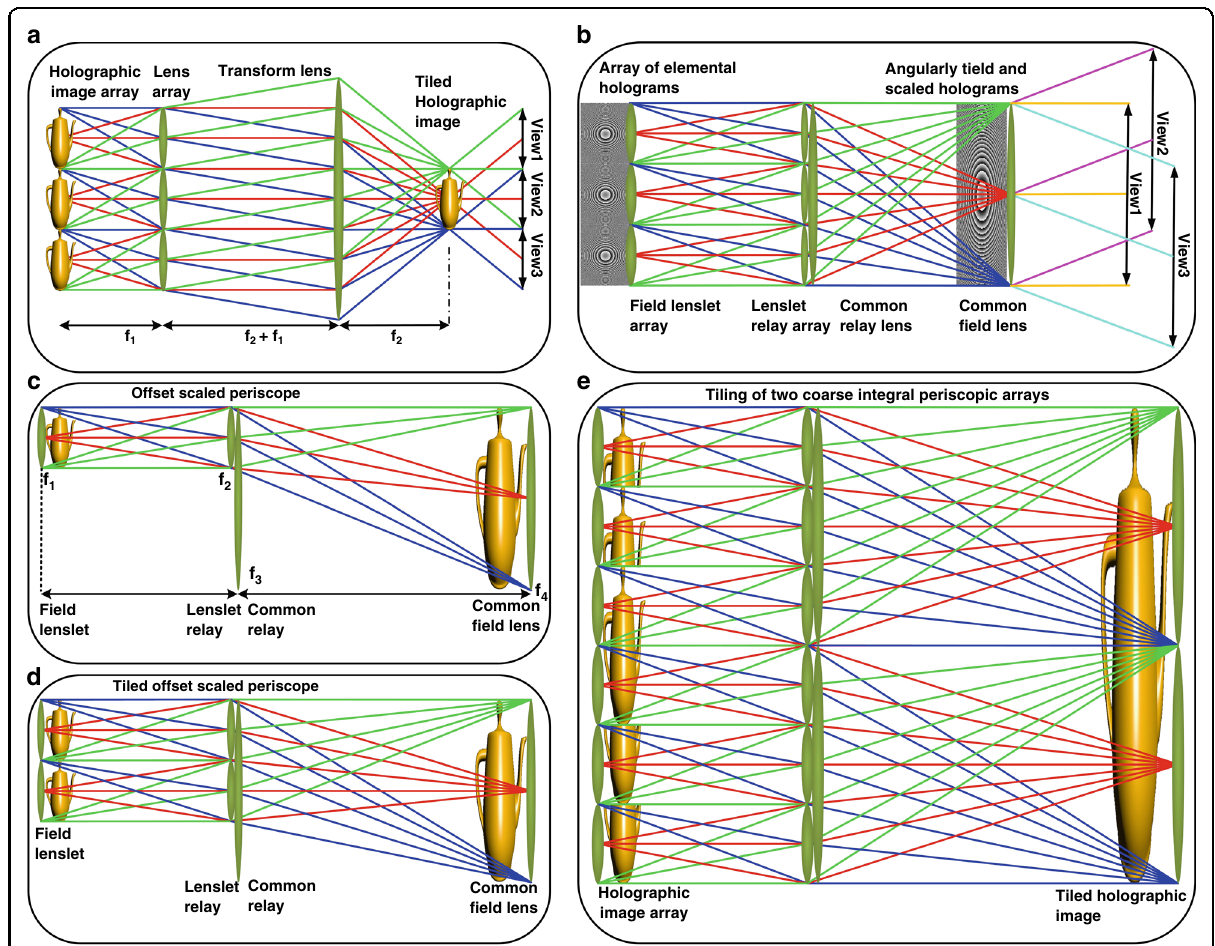
Fig. 8 Offset scaled periscope structures. a A standard 4f relay in the original CIH where the holographic image is smaller than the display optical system, b schematic illustration of the tileable CIH using an array of tiled offset scaled periscope optics, c offset scaled periscope optics, d two tiled offset scaled periscopes, and e spatial tiling of two coarse integral periscope optical